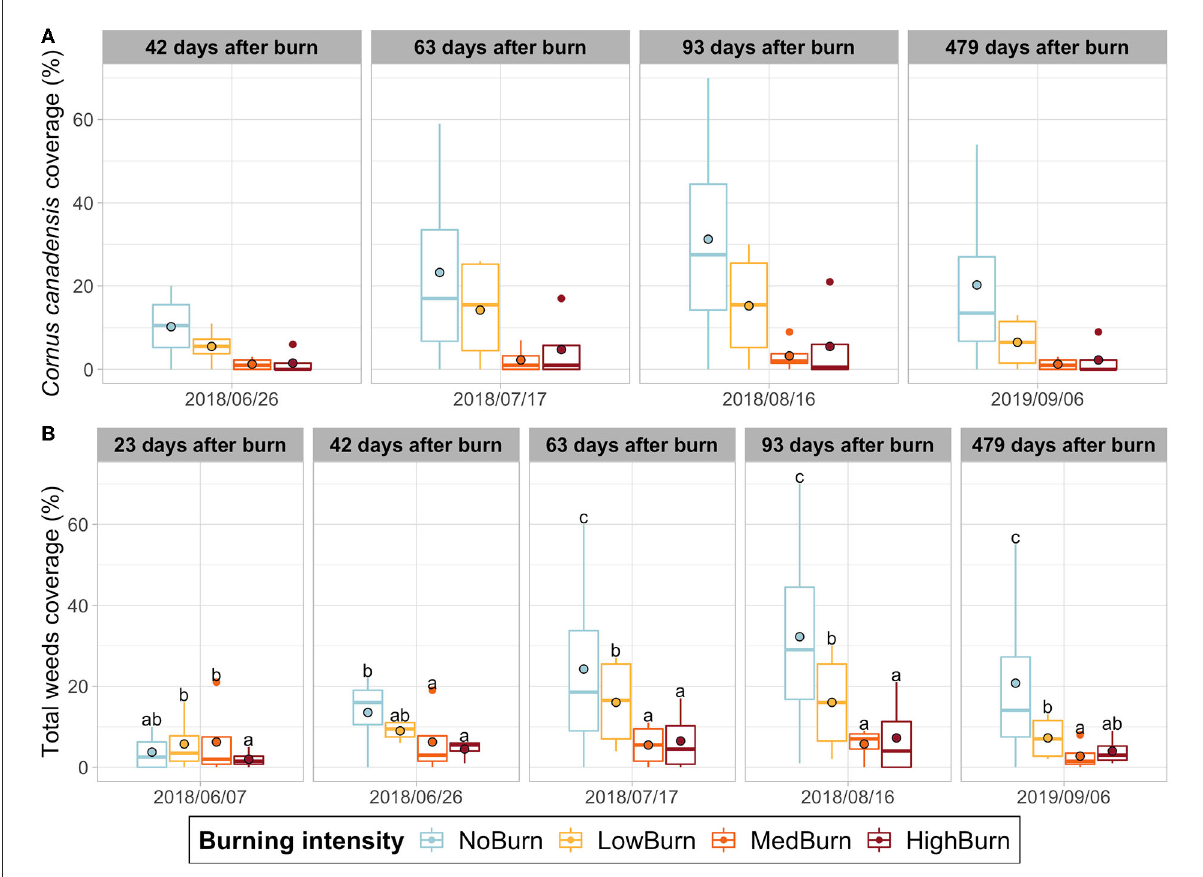
FIGURE2 Weed coverage over time. Mean value is indicated with a black-circled dot. (A) Cornus canadensis coverage. (B) Total weed coverage (pooled coverage of all the weed species observations). Significant difference in each sampling date is indicated by letters according to post hoc Tukey